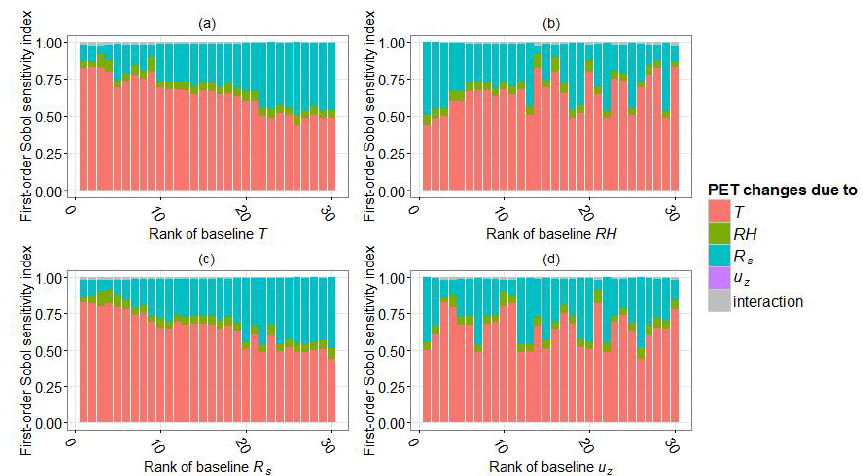
Figure 8. Sobol’ first-order sensitivity indices of the Priestley–Taylor model for changes in the four climate variables (colored) and their interaction effects (gray), plotted against the ranking of the average level of each climate variable at 30 study